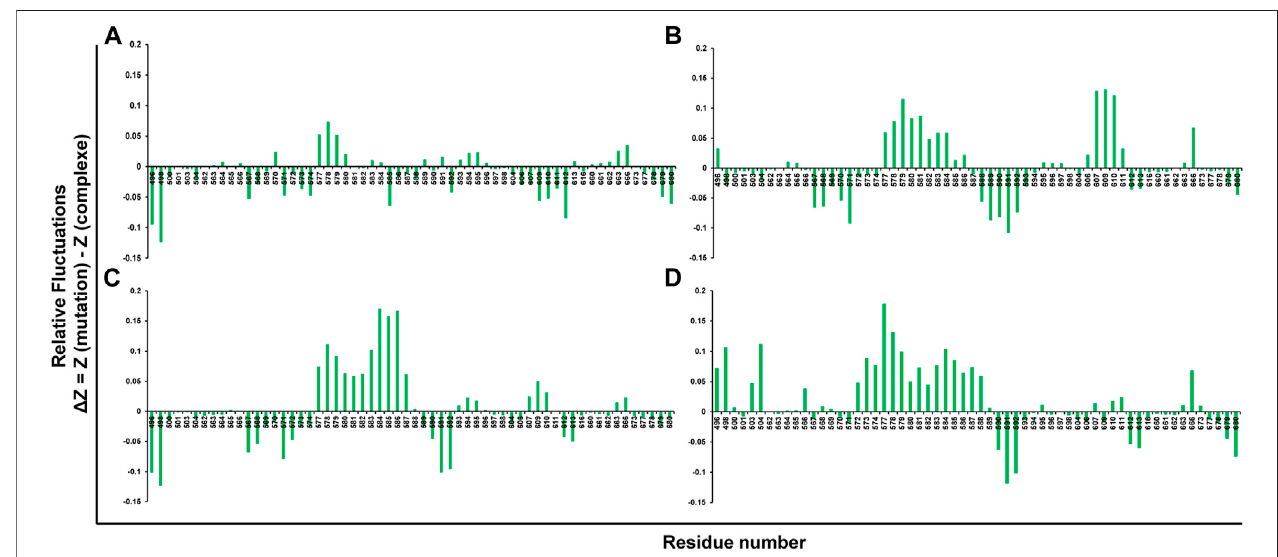
FIGURE 4 | Root mean square fl uctuations (RMSFs) of mutant systems of PARP12 and (A) ZINC03830332, (B) ZINC03830554, (C) ZINC03831186, and (D) ZINC03831189.